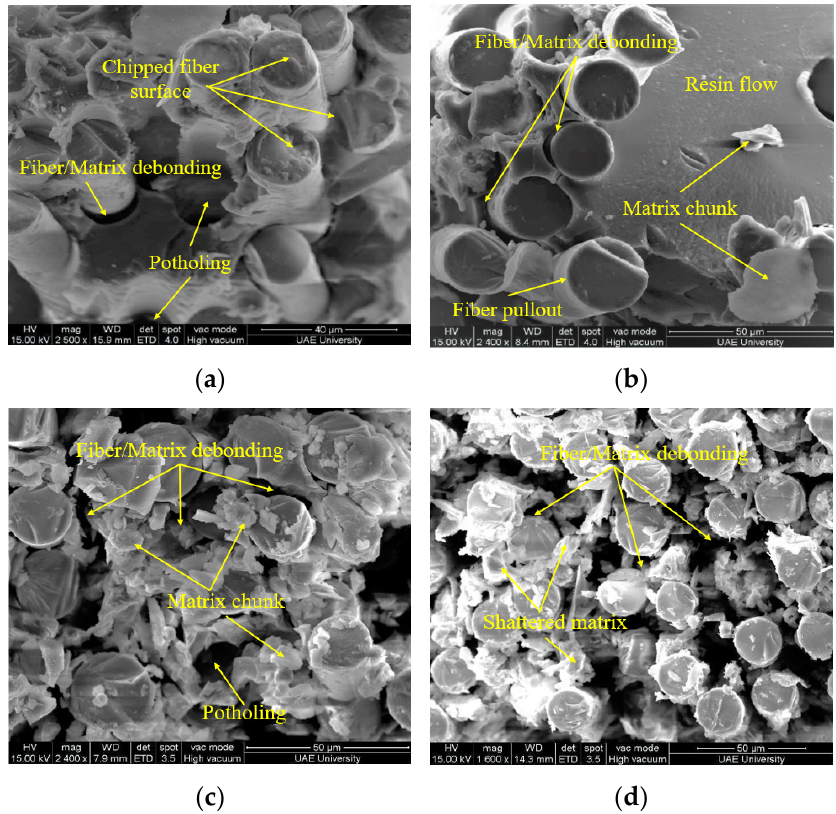
Figure 10. Failure surface of specimen immersed in sea water at 90 °C ( a ) 3 months, ( b ) 6 months, ( c ) 9 months and ( d ) 12 months. ( c ) 9 months and ( d ) 12